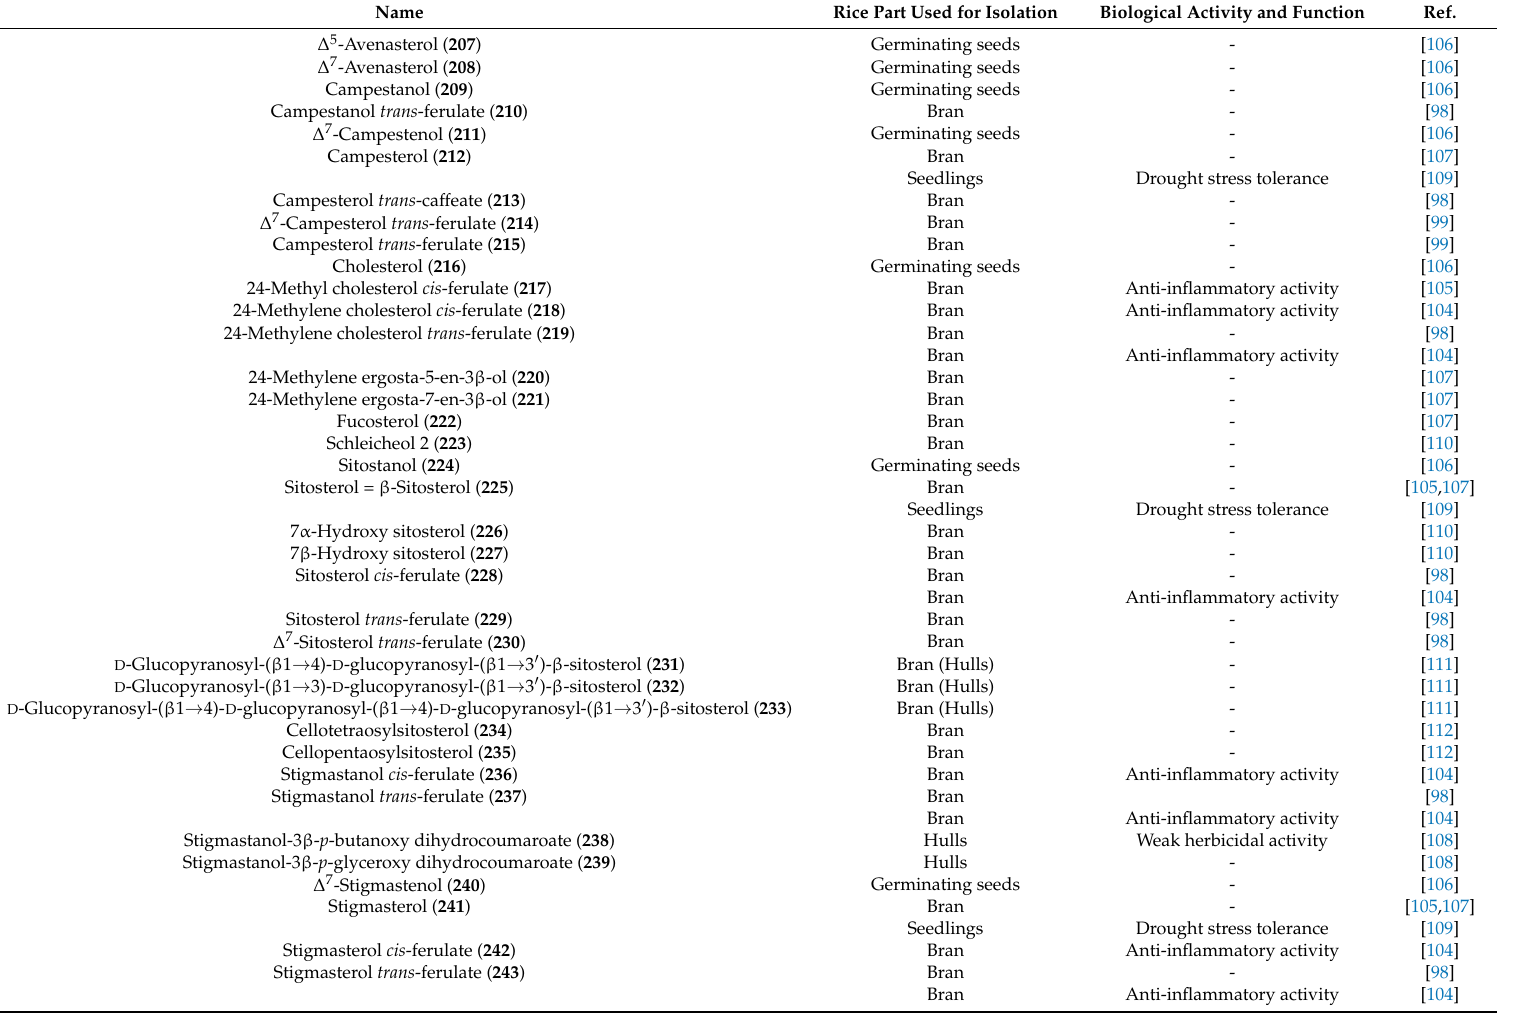
Table 7. Steroids and their biological